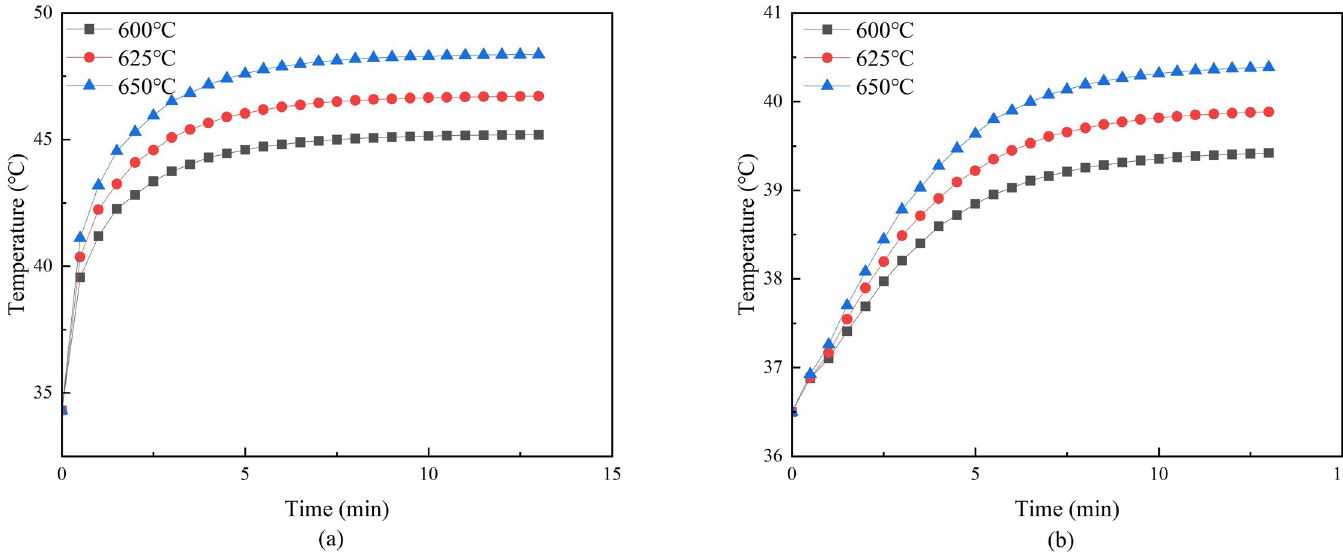
Fig 5. (a) Temperature curve of moxibustion point when moxa-burning temperature changes. (b) The temperature curve at 5mm under moxibustion point when moxa- burning temperature